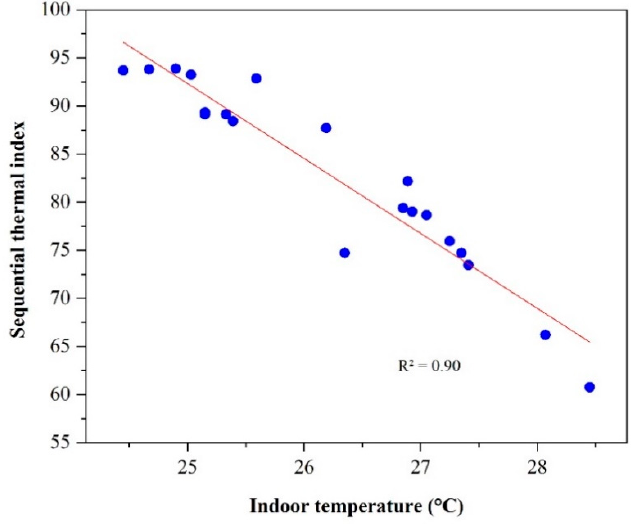
Figure 13. Indoor air temperature and overall insulation of clothing worn by patients.